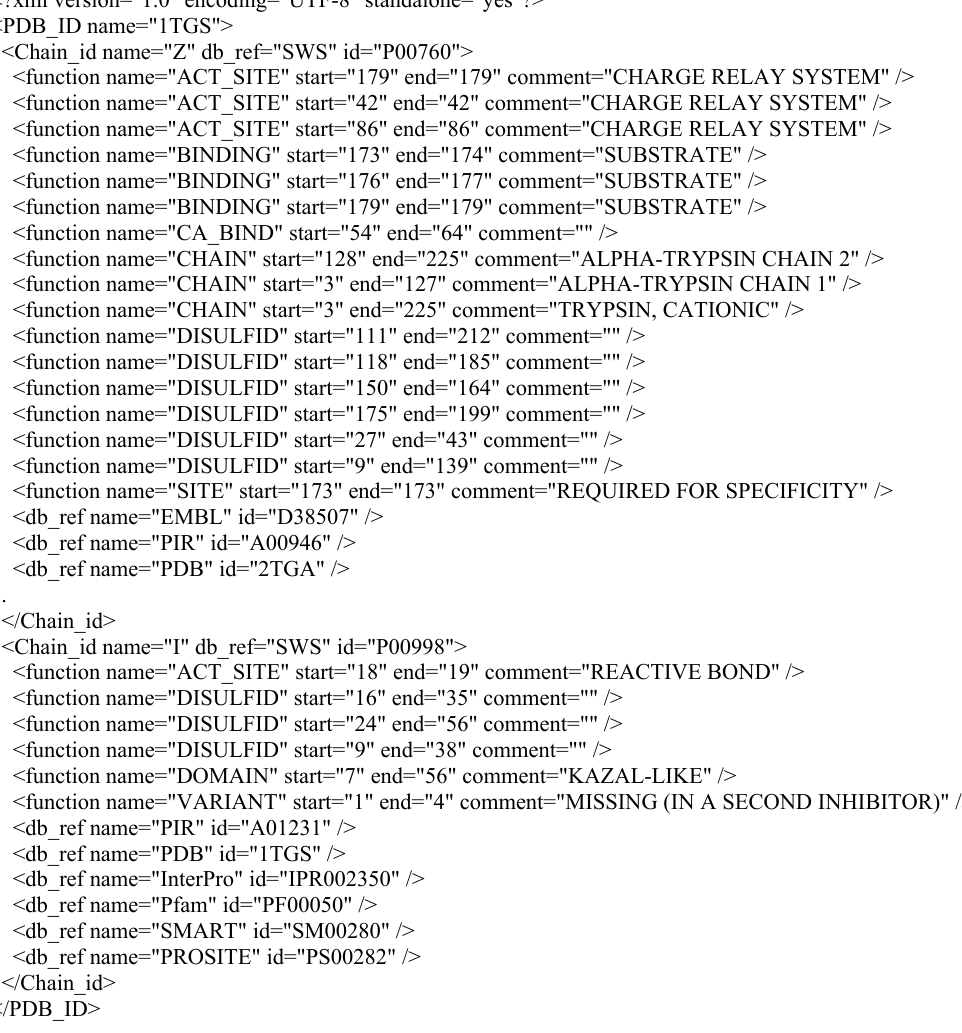
Fig. 3 Functional annotation for the PDB entry 1TGS in XML format. For chain Z and I the functions as annotated in SWISS-PROT entry P00760, respectively P00998 are listed within the function tag, e.g. for the Z chain the residues at position 42, 86 and 179 form the active site. Note, that the residues are numbered serially according their position within the chain and these positions differ from the amino acids number used in PDB. The start and end attribute indicates the start and end position of the function with the chain. The db_ref tags point to external databases, such as EMBL, PIR or